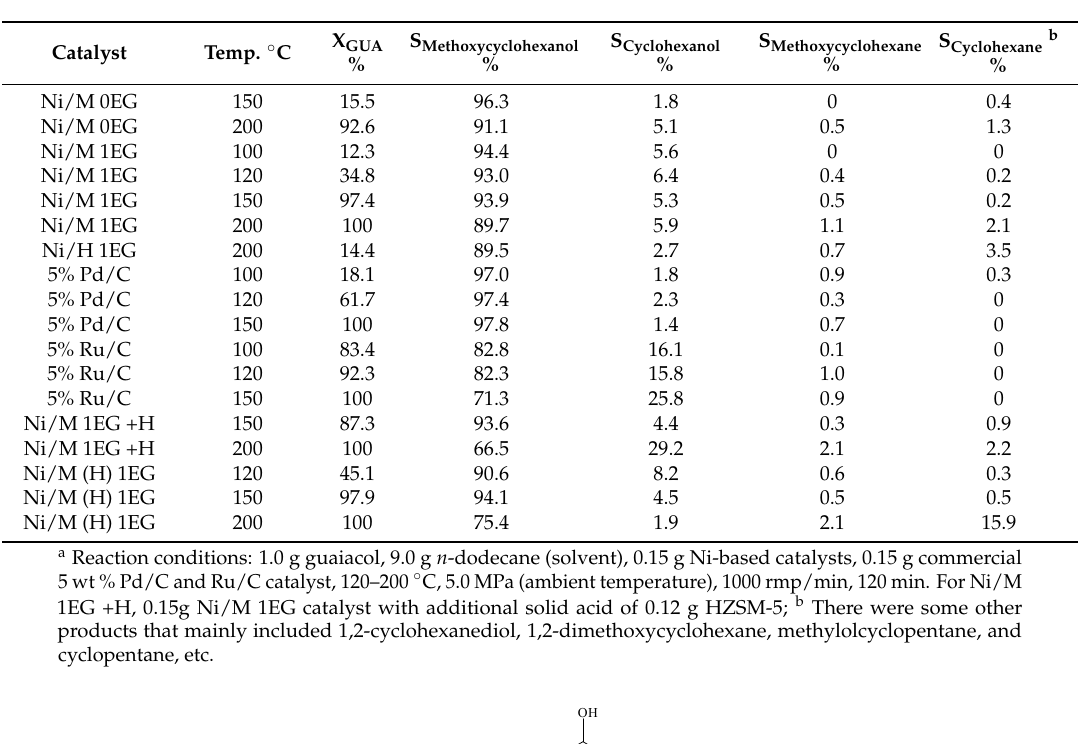
Table 3. Hydrogenation activity of guaiacol on various catalysts under low temperature a . Catalyst Temp. °C Ni/M 0EG